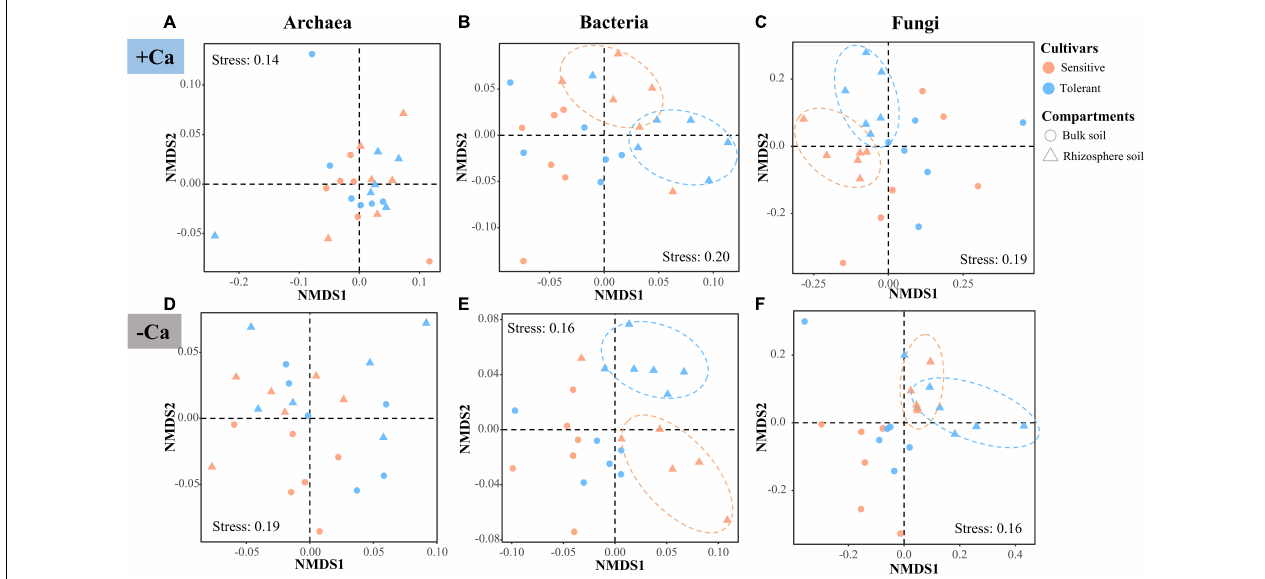
FIGURE 4 | β -diversity of archaea (A,D) , bacteria (B,E) , and fungi (C,F) according to the Bray–Curtis dissimilarity matrix in soil samples under liming (+ Ca) and non-liming ( − Ca) conditions. TABLE 3 | Mantel test of the correlation between soil properties according to the Euclidean distance and the community structure of archaea, bacteria, and fungi according to the Bray–Curtis distance. Environmental factors Bulk soil Rhizosphere soil Archaea Bacteria Fungi Archaea Bacteria